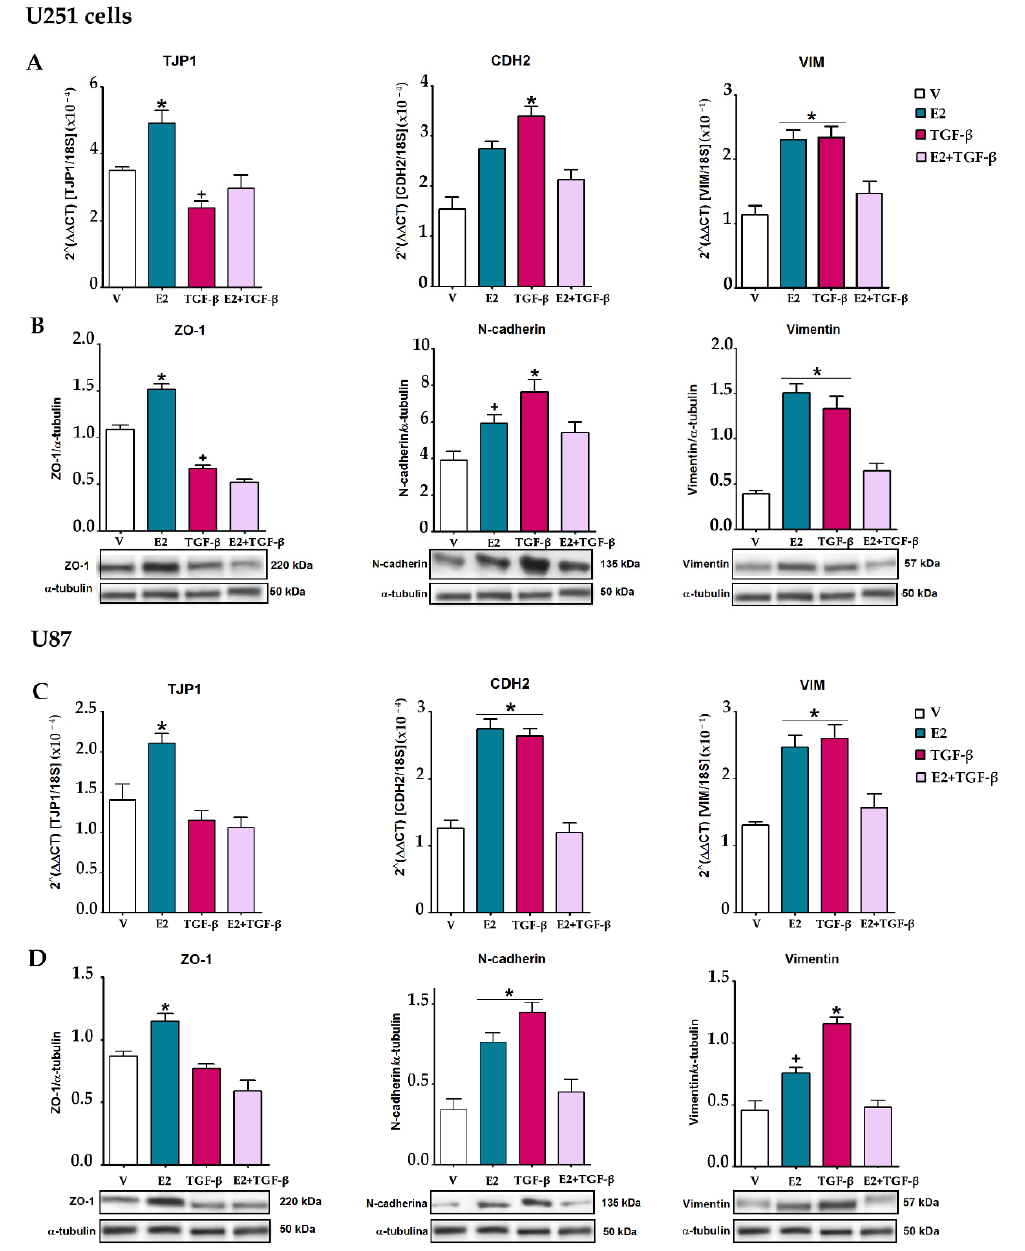
Figure 6. E2 and TGF- β -regulated epithelial–mesenchymal transition of human GBM-derived cells. U251 and U87 cells were treated with vehicle (V, 0.01% cyclodextrin + 0.0001% BSA), E2 (10 nM), TGF- β (10 ng/mL) and E2 + TGF- β for 48 h. ( A , C ) The expression of TJP1 (tight junction protein 1), CDH2 (cadherin-2), and VIM (vimentin) genes were quantified by RT-qPCR using the comparative method 2 ΔΔ Ct concerning the reference gene 18S rRNA. ( B , D ). The expression of zonula occludens 1 (ZO-1), N-cadherin, and vimentin proteins was determined by Western Blot. Densitometric analysis of EMT markers’ expression with their respective representative bands using α -tubulin as a load control is shown. Results are expressed as the mean ± standard error of the mean (SEM); n = 3; * p < 0.05 vs. V; + p < 0.05 vs. V and E2/TGF- β . These data showed that in human GBM-derived cells, the crosstalk between E2 and TGF- β interrupts both factors’ effects on cellular processes related to EMT activation, such as morphological changes, reorganization of actin filaments, and upregulation expression of molecular markers of the mesenchymal phenotype (Figure